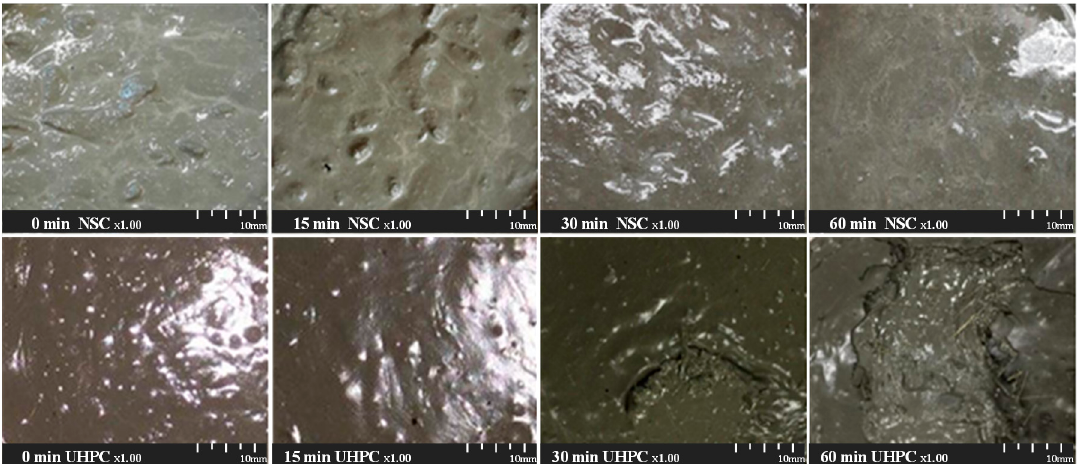
Figure 8. Temporal change in surface of cold joint regions of NSC and UHPC with delay.